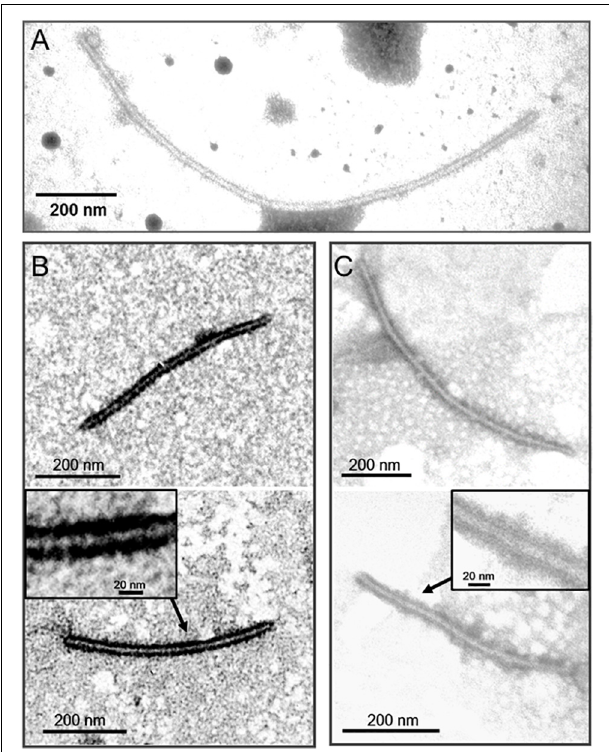
FIGURE 6 | Immunosorbent electron microscopy (ISEM) analysis using PAb-P5 in 4,000- (A,C) or 2,000-fold (B) dilution. The areas marked by arrow were enlarged in black